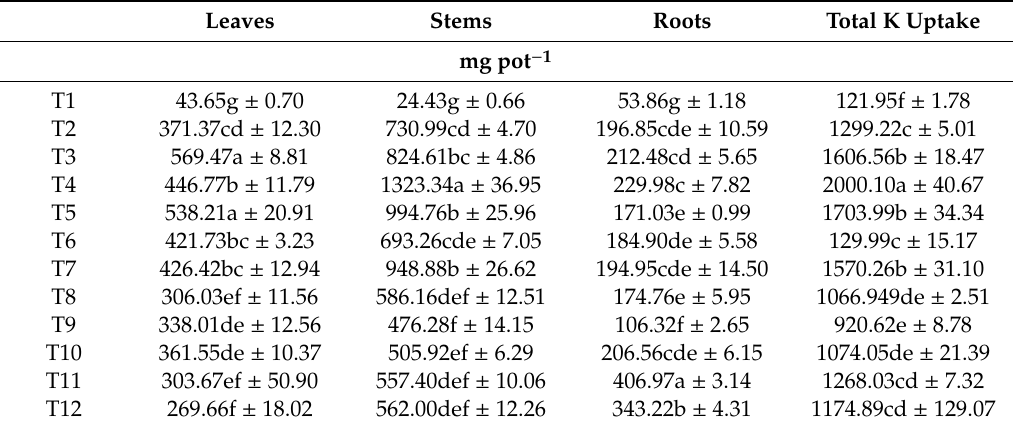
Table 6. E ff ects of treatments on potassium uptake of leaves, stems, and roots, and total potassium uptake of maize at tasseling